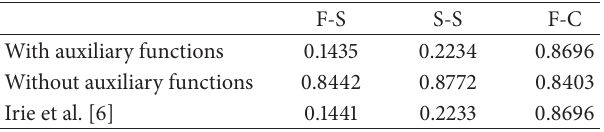
Table 2: Natural frequency parameters under different boundary conditions obtained by two types of weighting coefficients ( 𝑛 = 0 , 𝑚 = 0